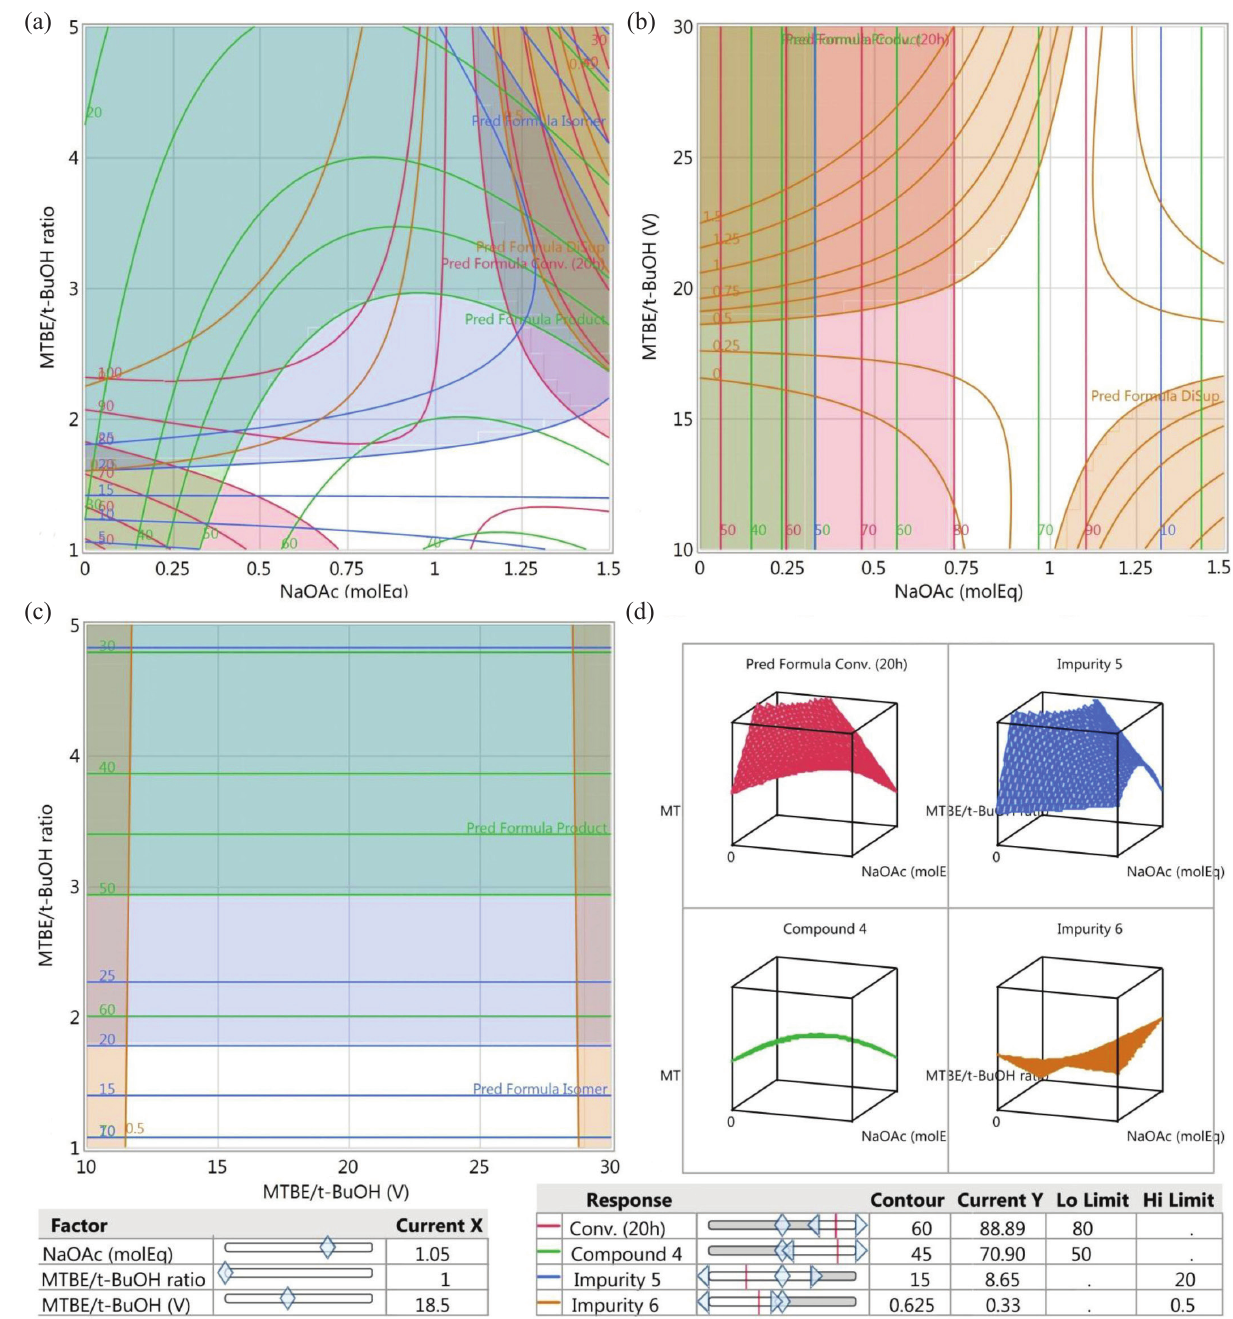
Fig. 3 – Prediction profiler contour plot: a) RSA for mixture of MTBE/t-BuoH and mol Eq of NaoAc, b) volumes and mol Eq of NaoAc, c) mixture of MTBE/t-BuoH and mol Eq of NaoAc, and d) surface